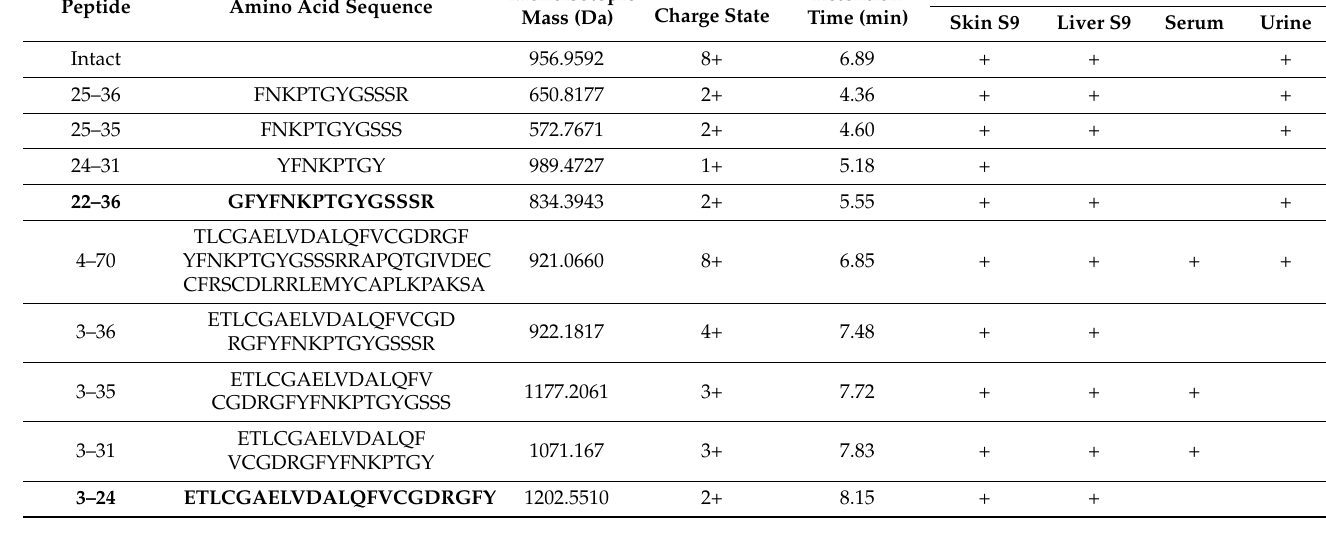
Table 2. Amino acid sequences and main characteristics of the metabolites derived from IGF-I using the presented IRIS approach. The most promising fragments for doping control analysis are highlighted in bold. (+ indicates the detection).